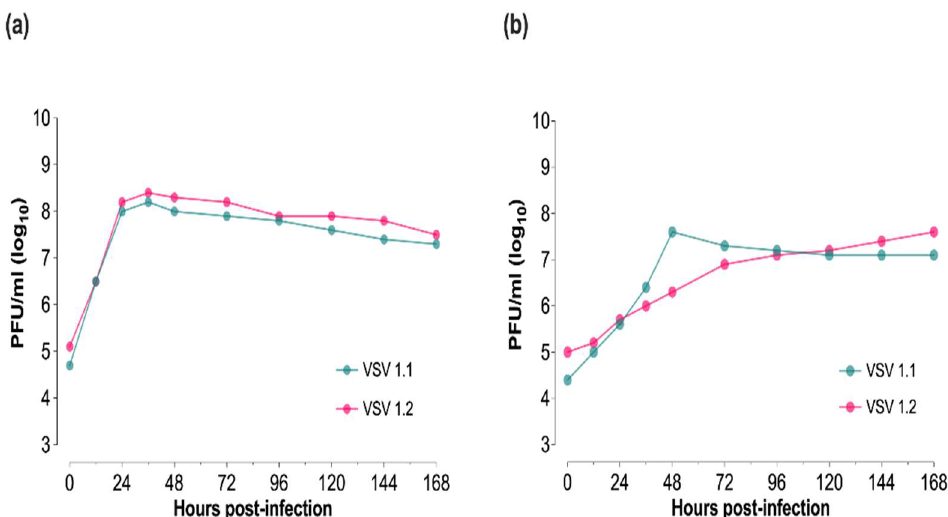
Figure 2. In vitro growth of recombinant VSV epidemic lineage 1.1 (rNJ0612NME6; teal) and the endemic lineage 1.2 (rNJ0806VCB; pink) in ( a ) porcine epithelial cells and ( b ) Culicoides W8 cells. All cell lines were infected at an MOI of 0.1, harvested at indicated time points, and titered by standard plaque assay in Vero cells.